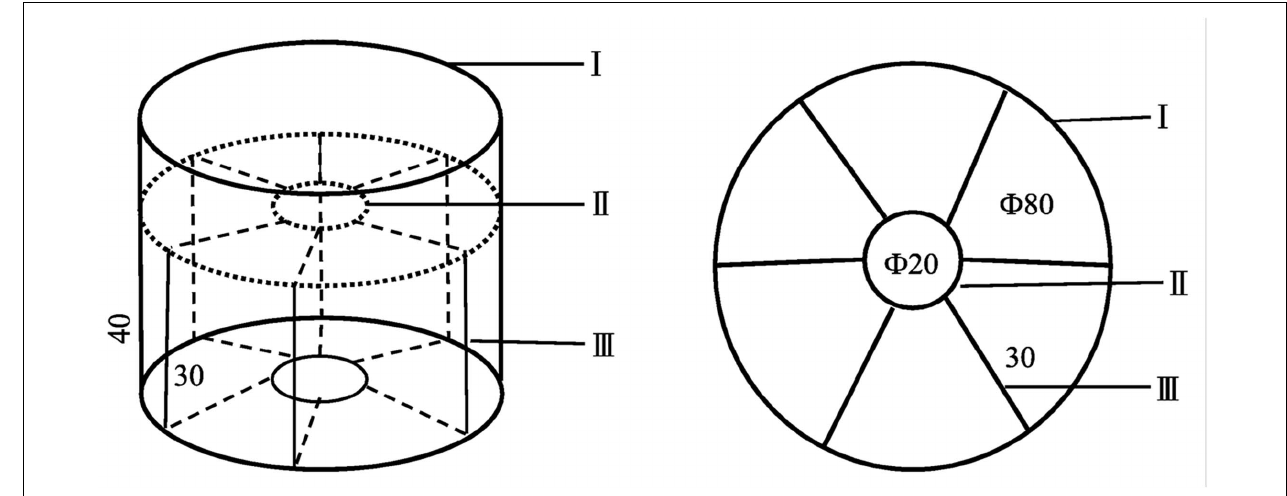
FIGURE 1 | Experimental device for selection behavior of P. aibuhitensis larvae. The device is a cylindrical container with a diameter of 80 cm and a height of 40 cm. Part I is the uppermost outer edge of the device. Part II’s center is cylindrical, with a 20 cm diameter, a 30 cm height, and a slightly sunken disk-shaped structure on the top. Part III is a square partition with a side length of 30 cm, which evenly divides the space around part II into six